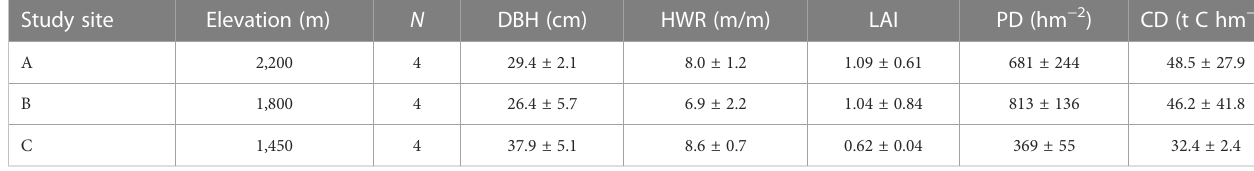
TABLE 1 Mean ( ± SD) of diameter at breast height (DBH, cm), crown height-to-width ratio (HWR, m/m), leaf area index (LAI) and population density (PD, hm − 2 ), and arbor biomass carbon density (CD, t C hm − 2 ) of Picea schrenkiana in the sites of 2,200-m, 1,800-m, and 1,450-m elevations at the northern slope of Mount Bogda, Tianshan Range, Xinjiang,